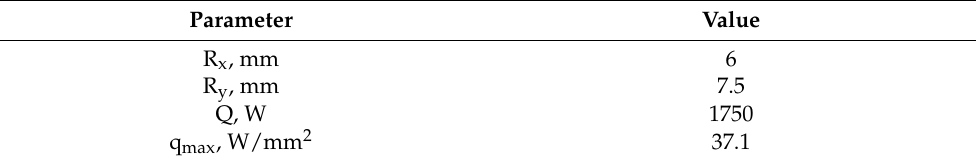
Table 3. The heat source